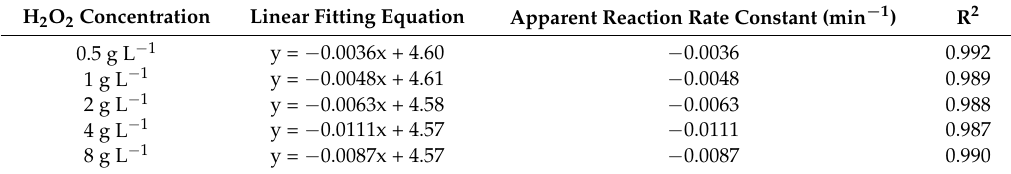
Figure 15. Effect of apparent rate constant on different catalyst concentrations. Table 7. Apparent reaction rate constant of different catalyst concentrations.